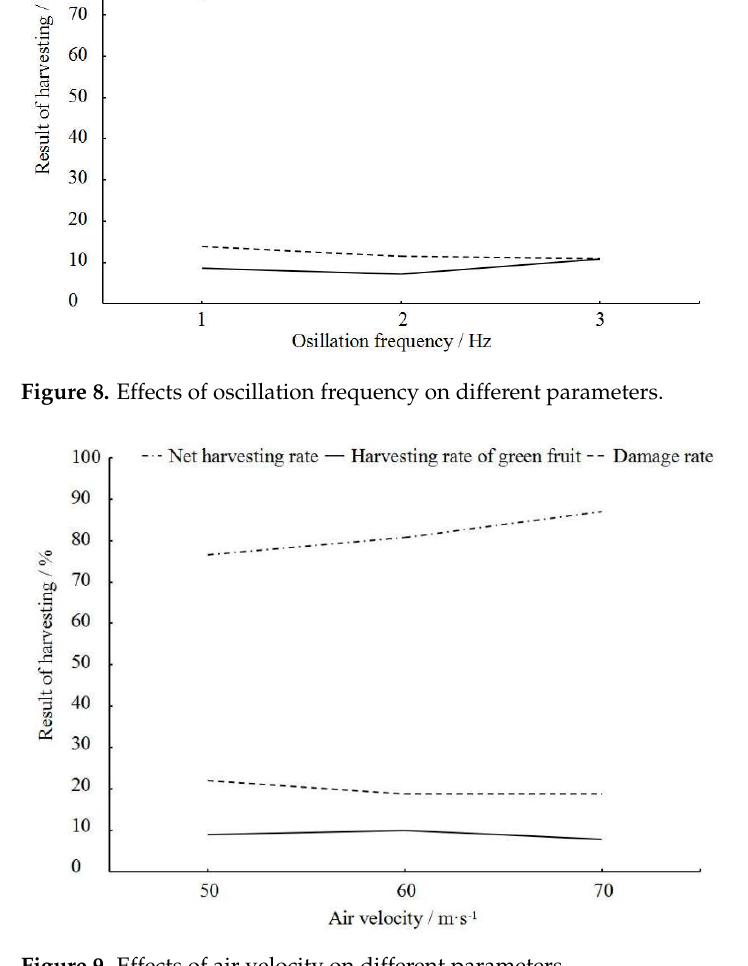
Figure 8. Effects of oscillation frequency on different parameters.